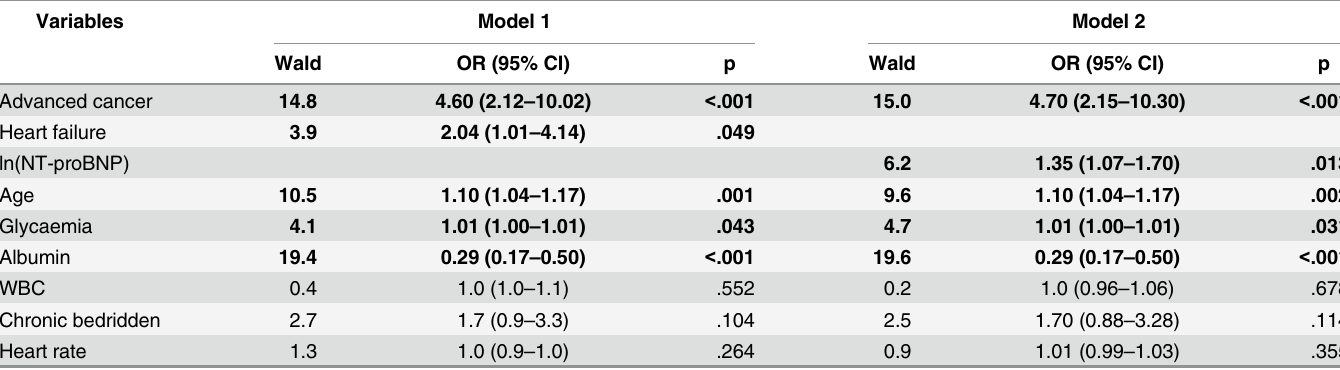
Table 4. Logistic Regression for In-hospital